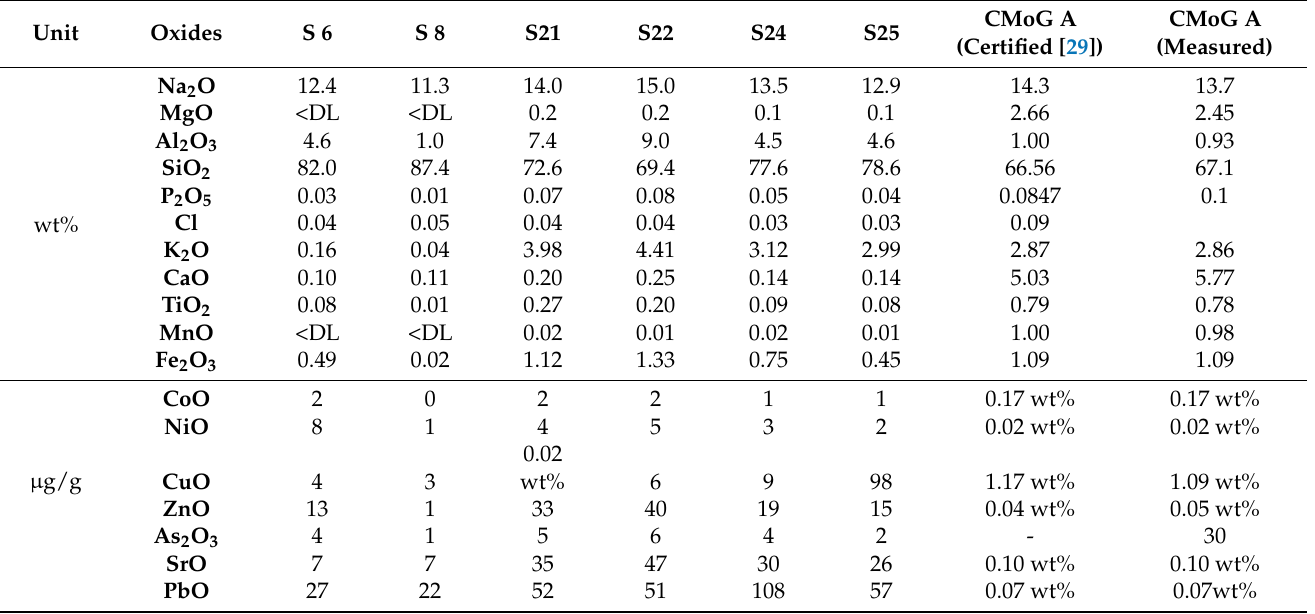
Table 3. Chemical composition of the synthesised glasses measured by LA-ICP-MS in weight percent of oxides and in µ